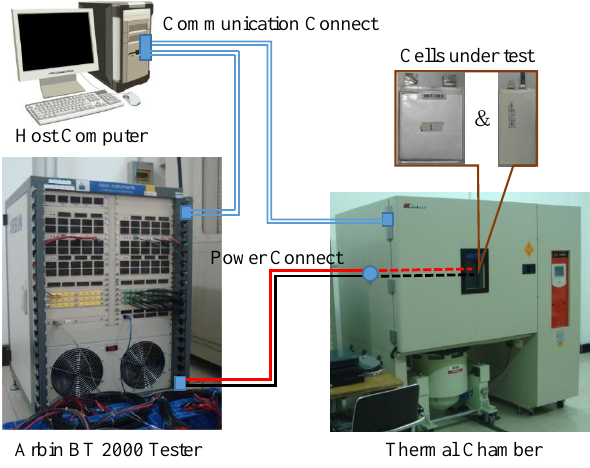
Figure 3. Configuration of the battery test bench.